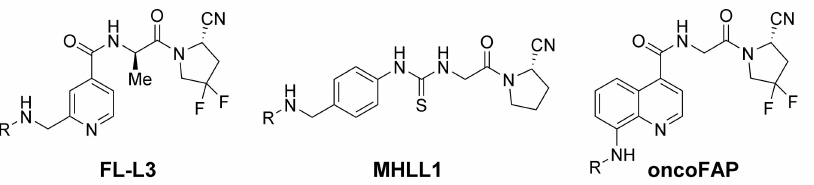
Figure 3. Small-molecule FAP-targeted radiotracers published by Roy, Langer and Millul [26–28]. R represents the chelating moiety, which is eventually attached by an appropriate